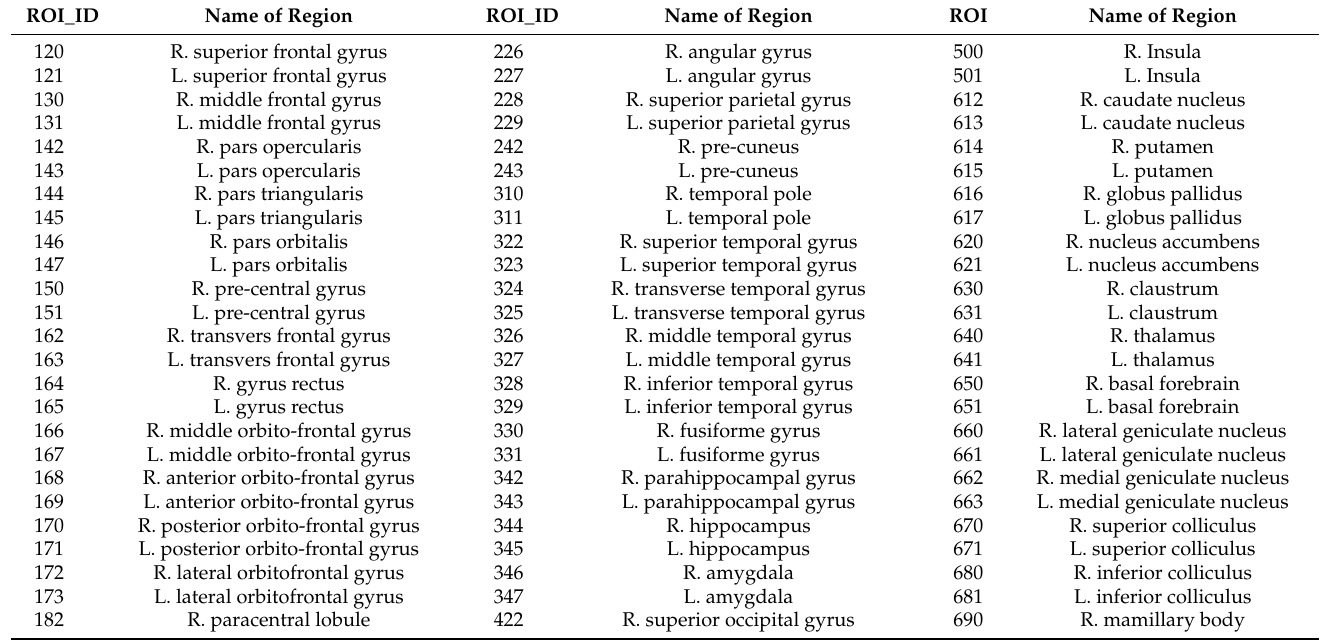
Table 1. The region of interest (ROI) used in the statistical calculations. R refers to the right region of the brain, and L refers to the left